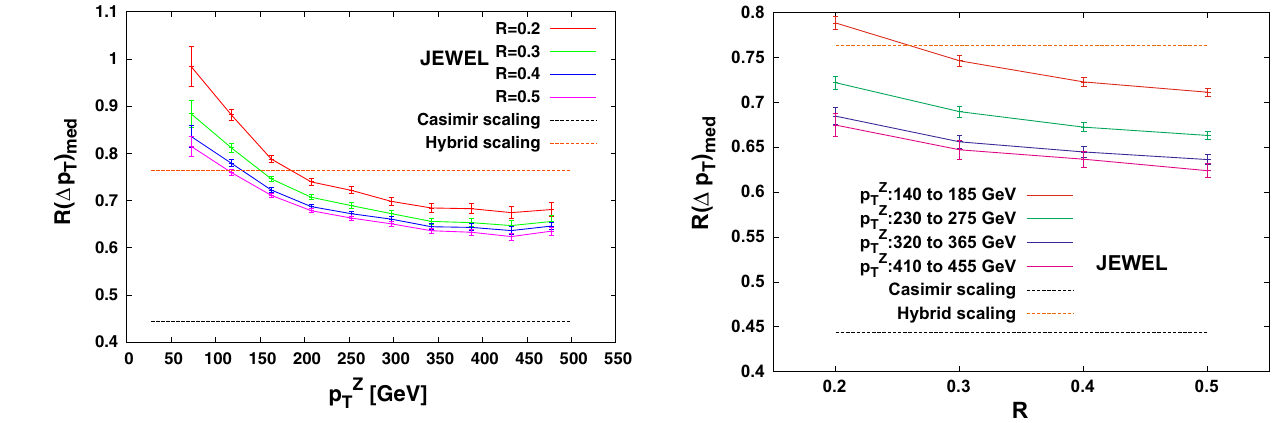
in vacuum, but scaled by a multiplicative constant.